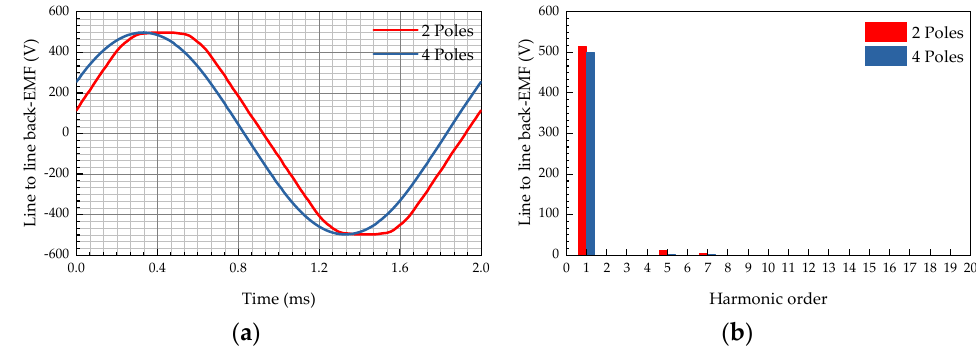
Figure 10. Line to line back − EMF of two ‐ pole and fours ‐ pole motor at no load: ( a ) line to line back ‐ EMF waveform; ( b ) Fourier transform.